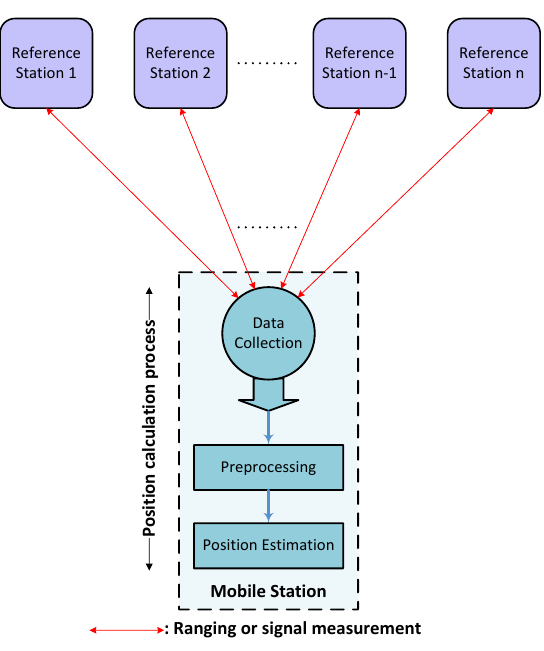
Figure 3. Components’ interaction.